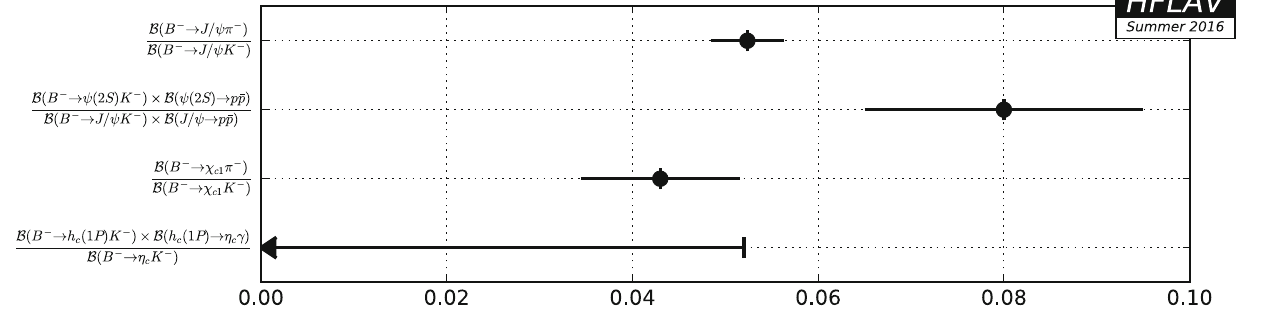
Fig. 138 Summary of the averages from Table